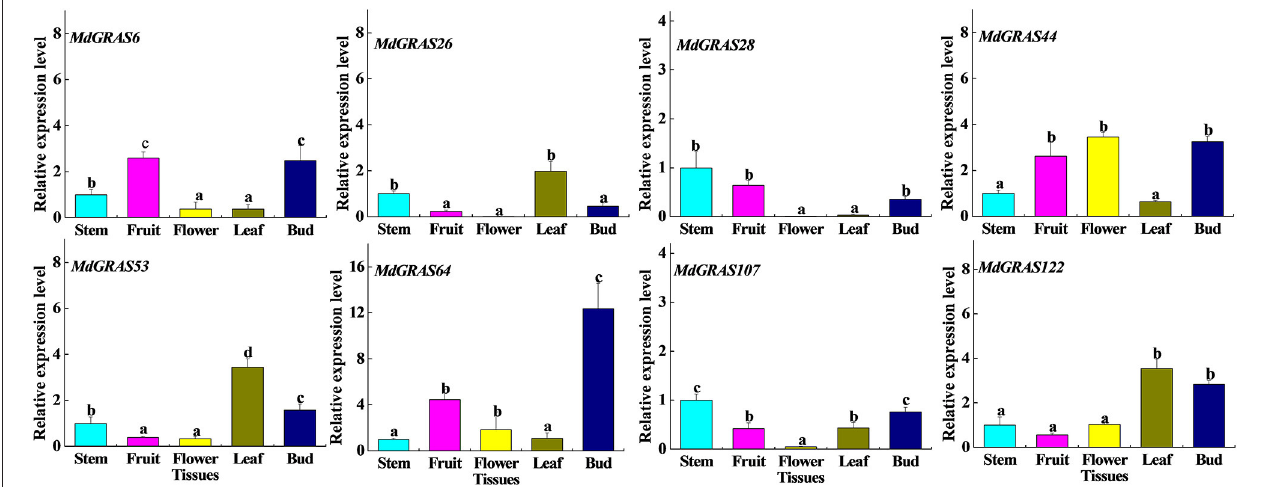
FIGURE 6 | Expression of candidate MdGRAS genes in different tissues. Each value represents the mean ± standard error of three replicates. Means followed by small letters (a, b, and c) are significantly different at a level of